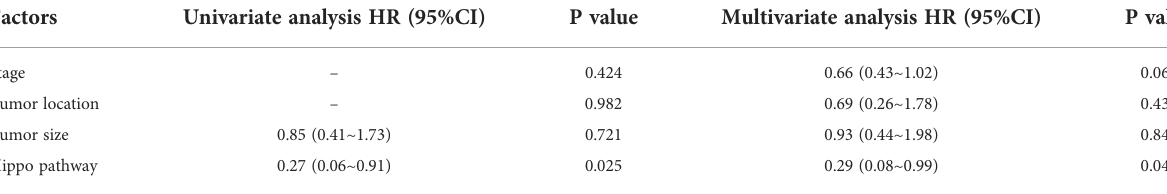
TABLE 2 Univariant and multivariant analysis of patients strati fi ed by young (<50) and old ( ≥ 50). Factors